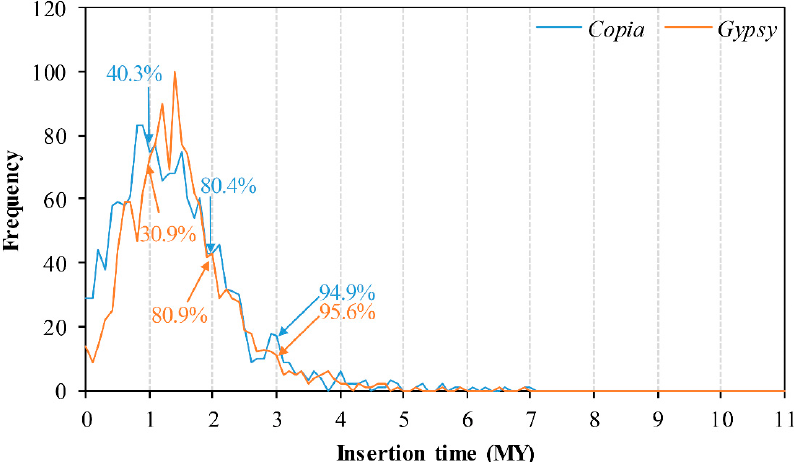
Figure 5. Overall insertion time distribution and amplification of full-length elements in the mulberry genome. Insertion times were split into bins of 0.1 MY. The x -axis denotes insertion time ranges for all full-length elements of Copia and Gypsy . The y -axis denotes the frequency of element insertions per time interval. The distribution pattern does not resemble an exponential distribution.